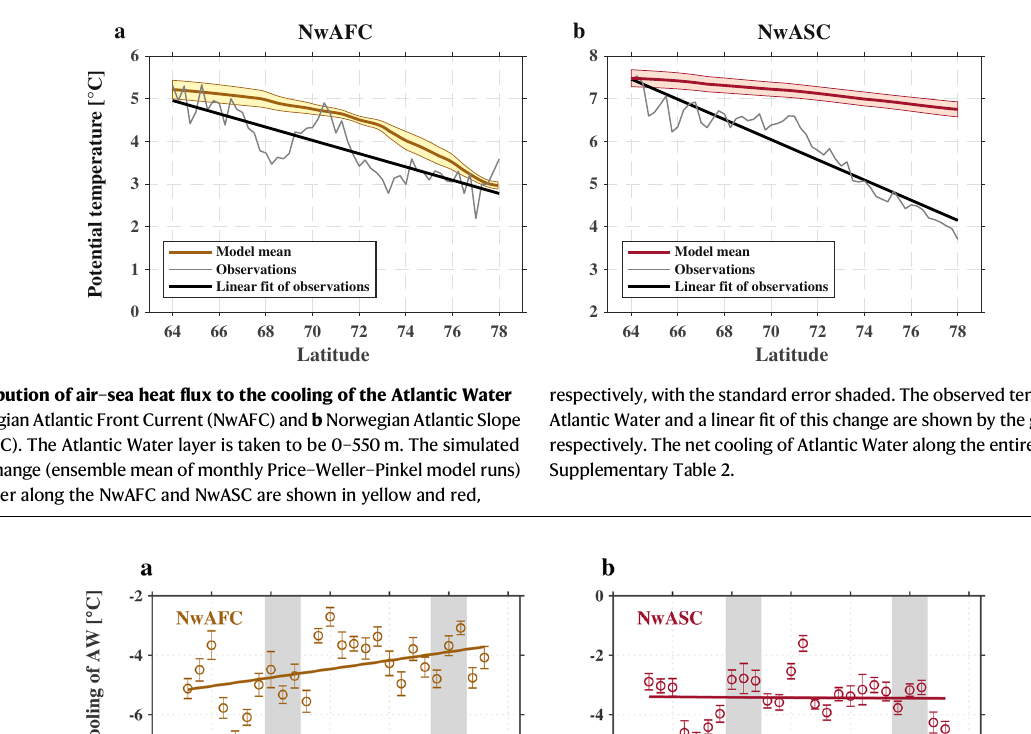
the along-pathway cooling of Atlantic Water for each year). The gray shading indicates the two time periods considered in the text: 2000 – 2002 and 2014 – 2016 (see Supplementary Fig. 6 for the changes of air – sea turbulent heat fl ux, surface alongstream velocity, and sea surface height between these two time